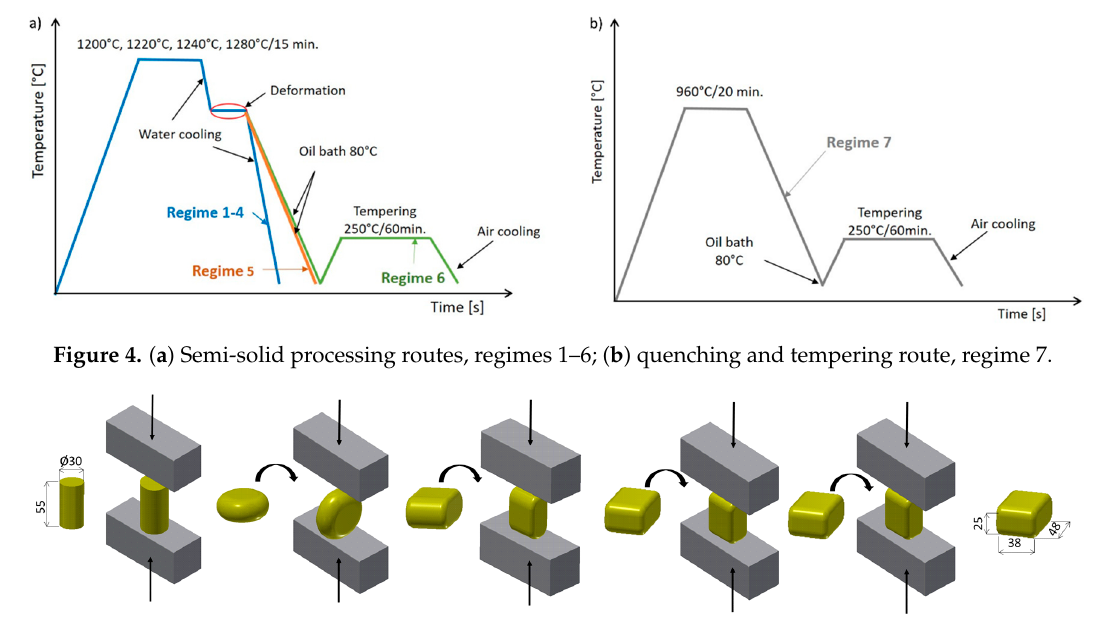
Figure 5. Scheme of the forging process at the temperature of 1080 °C.